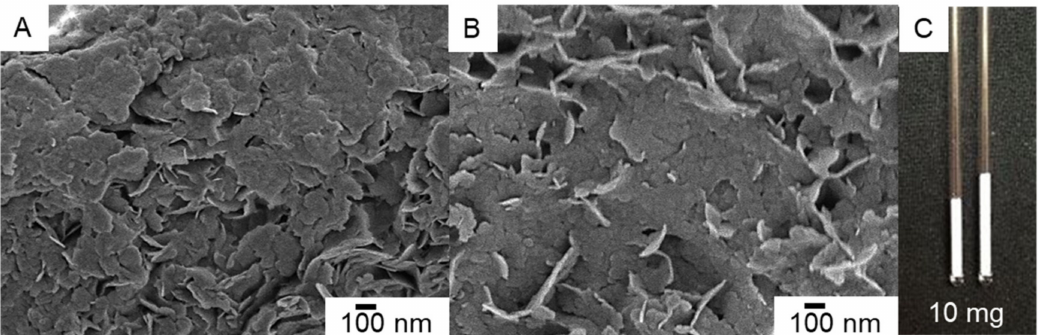
Figure 5. SEM images of MgGa(I)-0.06 ( A ) and MgGa(I)-0.06_F ( B ). ( C ) Photograph of the products in a capillary tube to show the difference in the density, 10 mg of sample in the capillary without compressing; MgGa(I)-0.06 (left) and MgGa(I)-0.06_F (right).